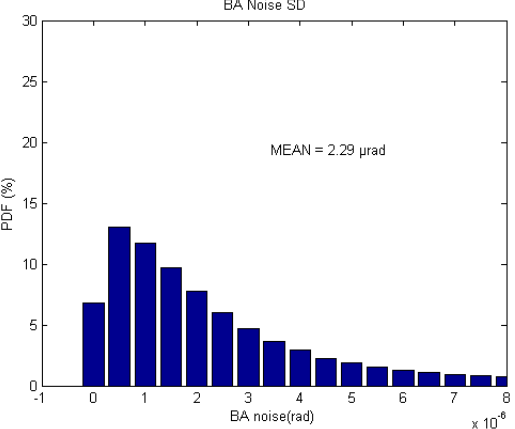
Figure 8. Probability distribution function (PDF) of bending angle (BA) noise in terms of standard deviation for each occultation be- tween 60 and 80km heights for ∼ 18000 GNOS GPS profiles from November to December 2013.